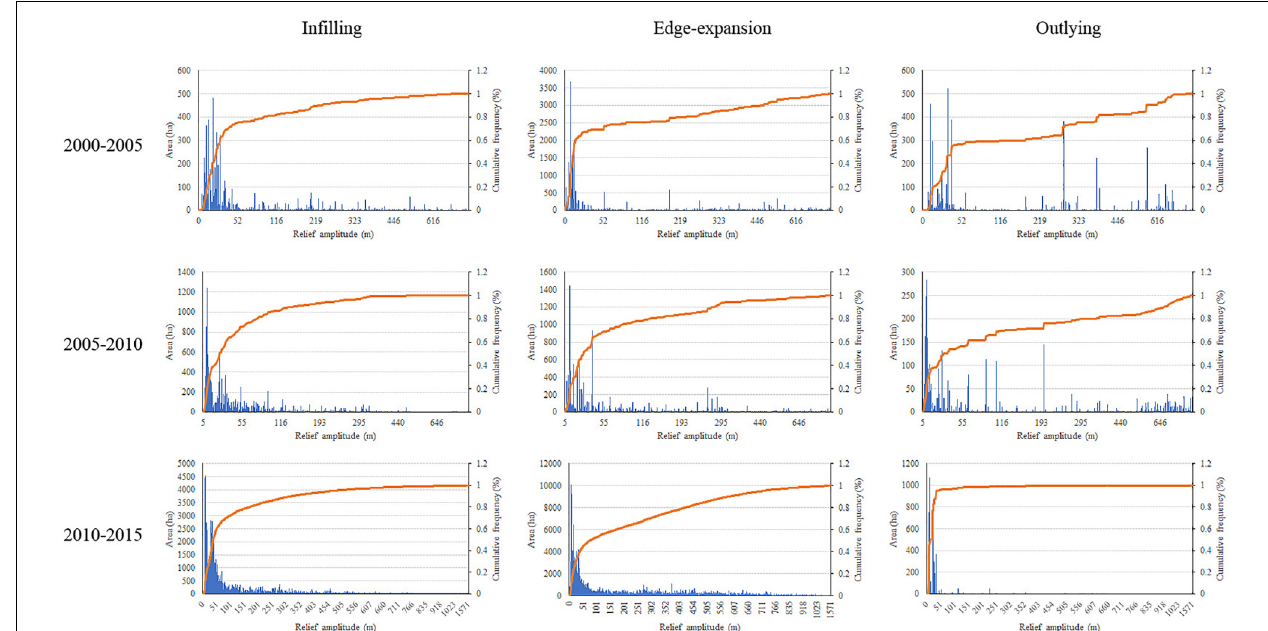
FIGURE 4 | Topographic relief effect in cropland expansion trajectories in YRDUA from 2000 to 2015.